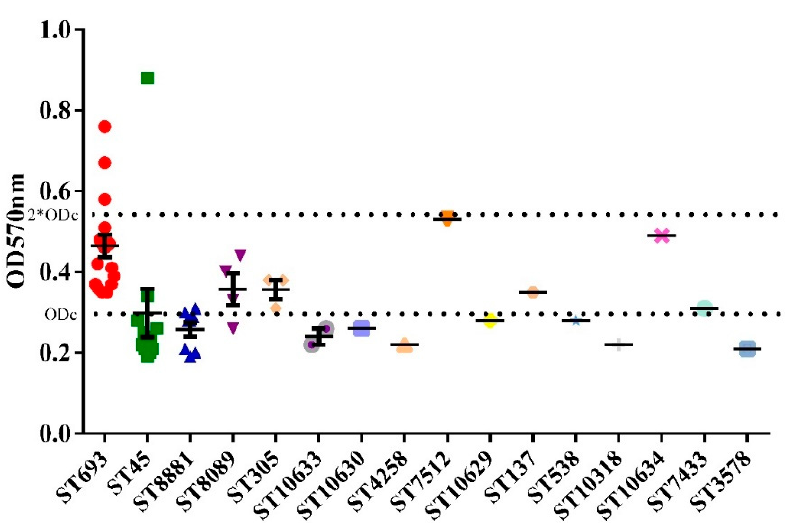
Figure 2. Biofilm-forming abilities of 57 Campylobacter isolates belonging to different sequence types. The bottom dotted line indicates the cutoff value (ODc = 0.2835), and the top dotted line indicates the two-fold cutoff value (ODc = 0.567). Based on the OD values, the strains were classified into three categories: non-biofilm producer (OD ≤ ODc), weak biofilm producer (ODc <OD ≤ 2 × ODc), and strong biofilm producer (2 × ODc < OD).